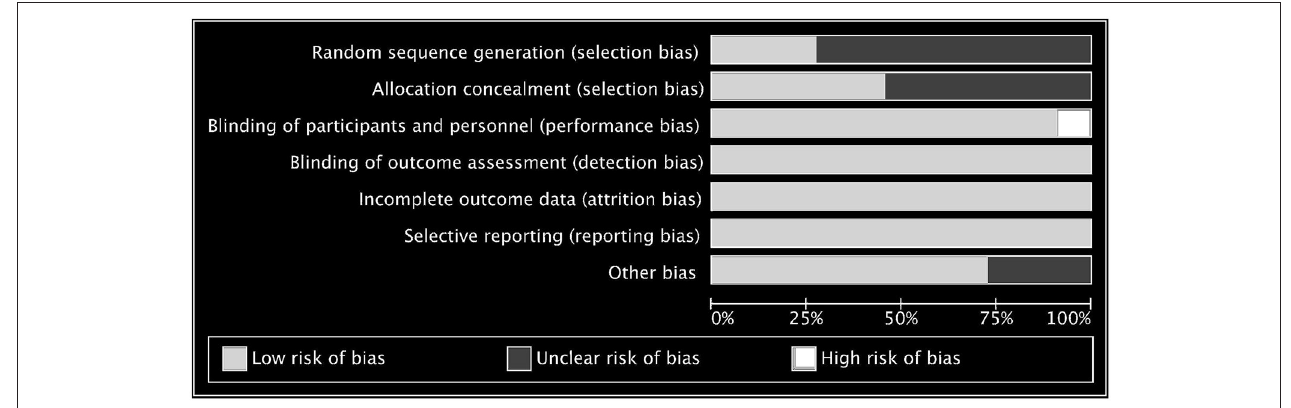
FIGURE 3 | The risk of bias assessment for the individual domains.